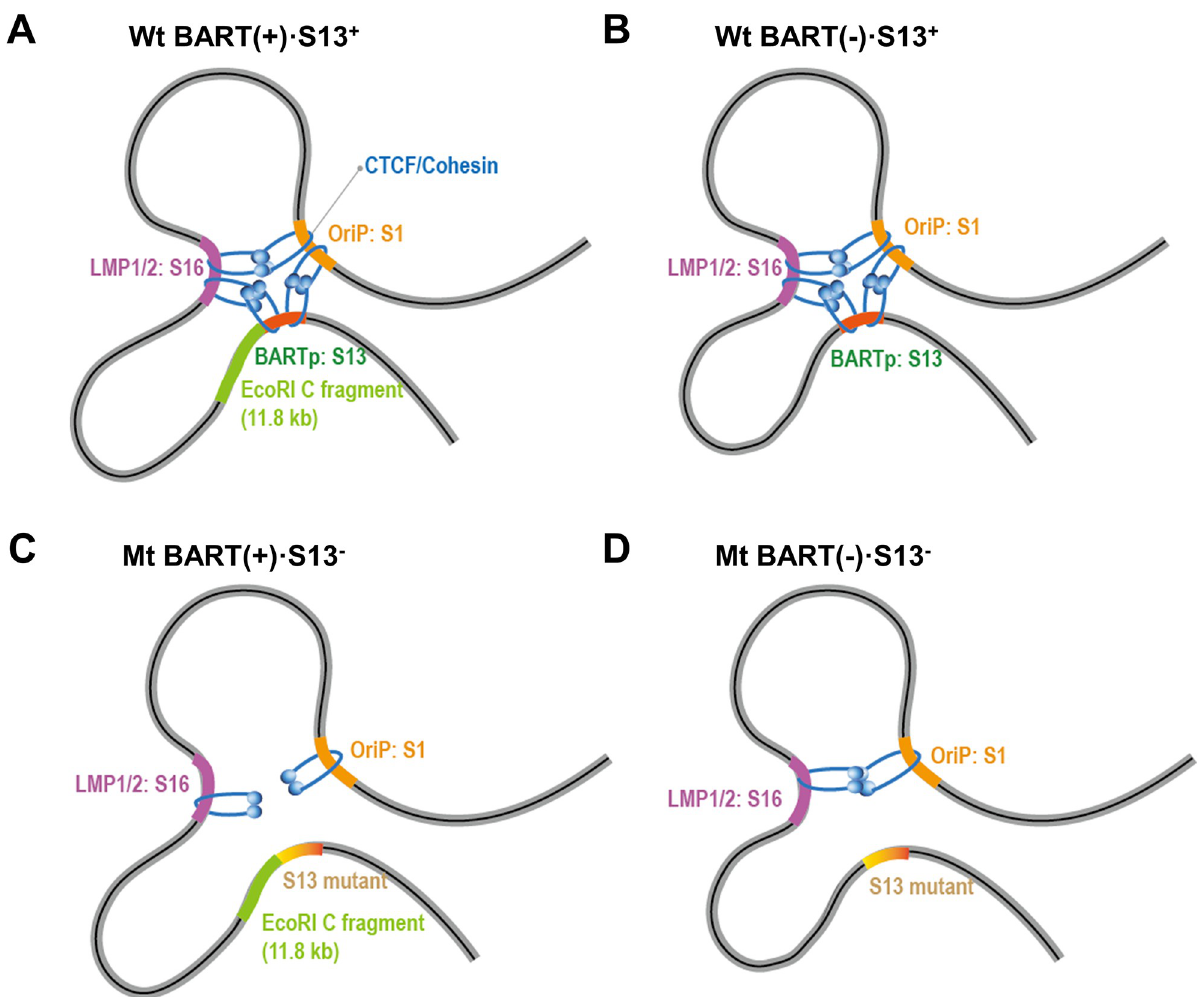
Fig 10. Simple diagrams explaining the different effects of the S13 mutation on the formation of EBV chromatin loops. Deletion of the S13 locus causes distorted CTCF distribution in EBV genomes. Compared to BART(+) � S13+ EBV genome (A) and BART(-) � S13+ EBV genome (B) , CTCF was enriched at the S15 and S16 loci in the Mt BART(+) � S13- EBV genome (C) , but less CTCF was enriched at the S15 and S16 loci in the Mt BART(-) � S13- EBV genome (D) . Consequently, deletion of the S13 locus severely damaged S1 and S16 interactions in the Mt BART(+) � S13- EBV genome than in the Mt BART(-) � S13- EBV genome. BARTp represents a CTCF-binding site on the BART promoter.